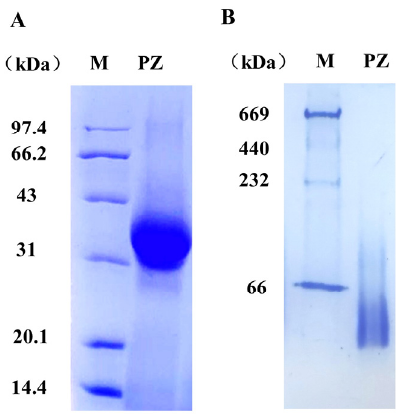
Figure 1. SDS-PAGE ( A ) analyses and native PAGE ( B ) analyses of PZ.